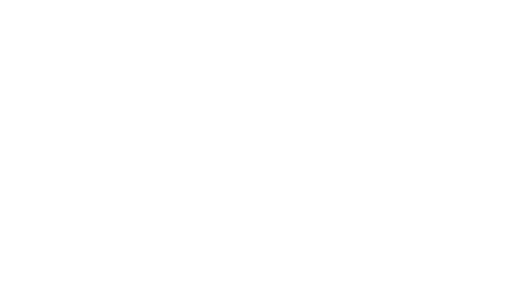
Table 4. postoperative events and complications.